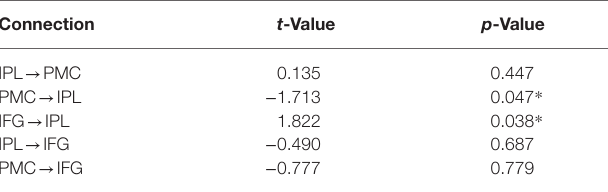
TABLE 5 | Results of paired-sample t -test for comparing the modulatory effects in GenA vs. GenV.